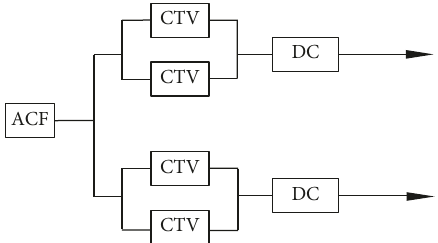
Figure 3: Equivalent block diagram of the UHVDC transmission